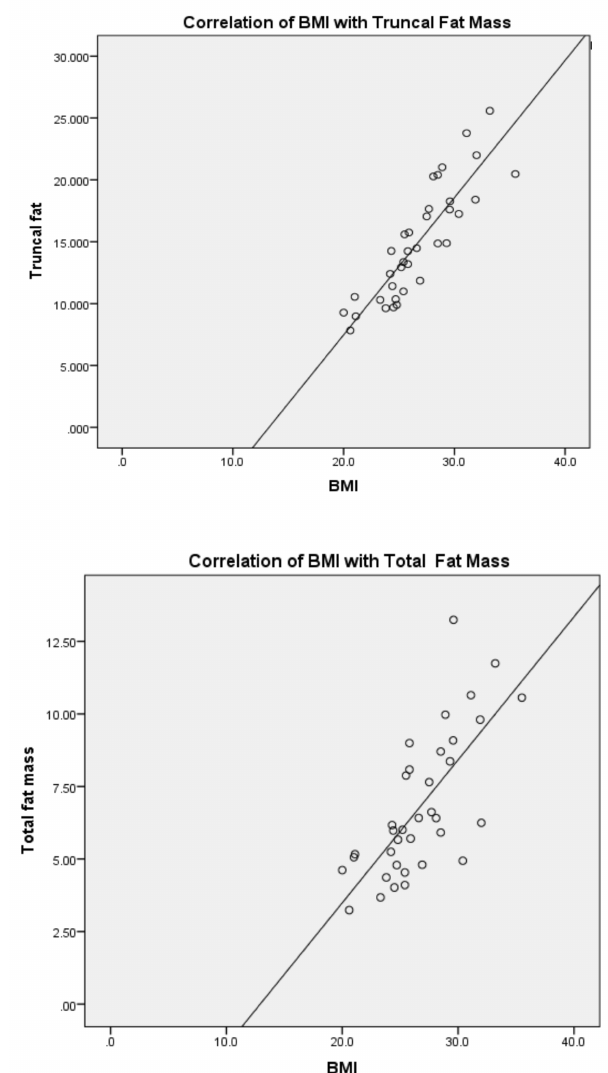
Figure 1. Showing the correlation between BMI, android fat, total fat mass, total truncal mass, and truncal fat in people with type 2